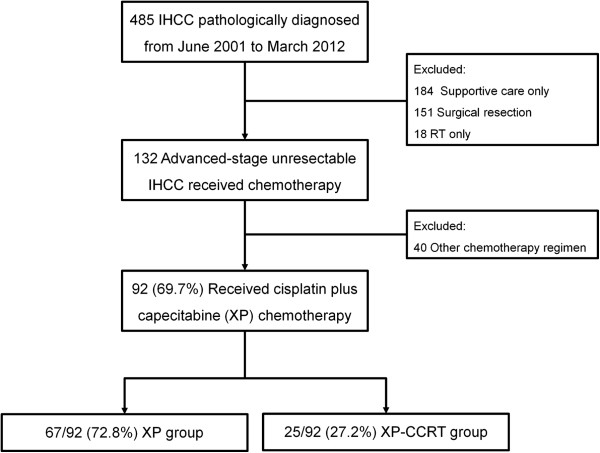
Patient flow chart.